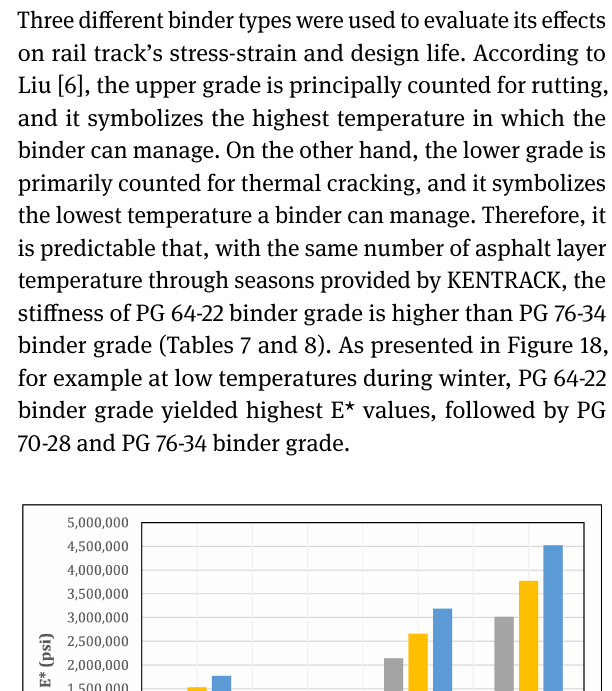
Figure19showstheeffectofthreedifferentbindertypes on subgrade compressive stress and subgrade service life in the asphaltic overlayment rail